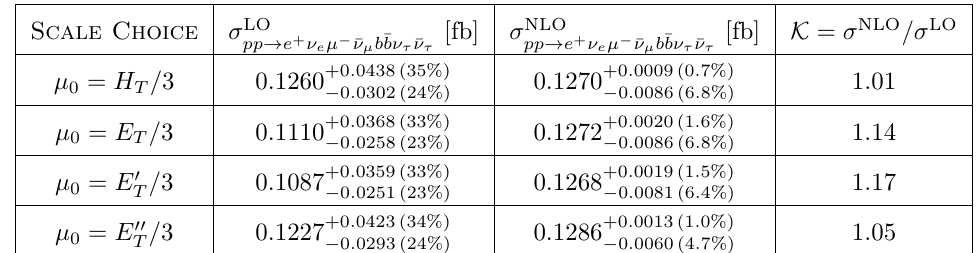
Table 3 . LO and NLO cross sections for the pp II with p s = 13 TeV. Results for various scale choices are presented. Also included are theoretical errors as obtained from the scale variation. In the last column the to LO cross section, is given. The LO and NLO CT14 PDF sets are